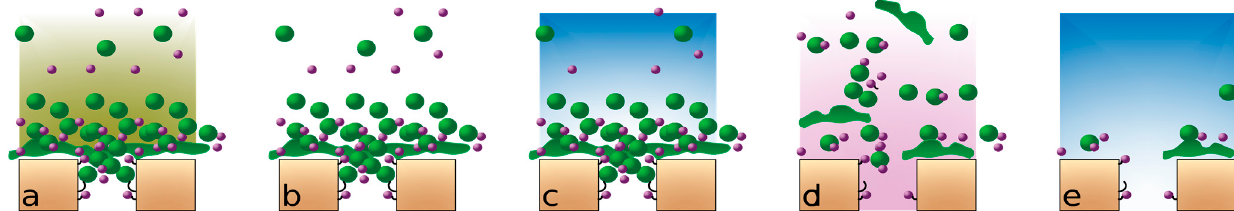
Figure 2. Typical membrane cleaning-in-place (CIP) procedure sequence including cake layer before treatment ( a ), draining ( b ) rinsing ( c ), chemical cleaning ( d ), and final rinsing ( e ).